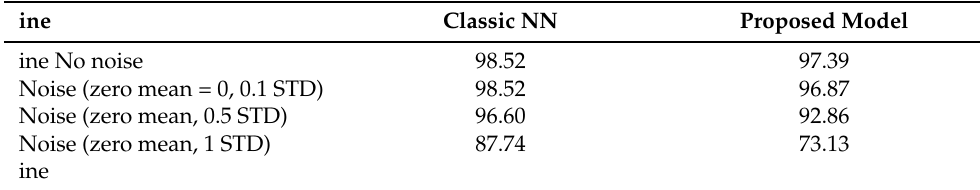
Table 4. Generalization accuracy (%) on holdout test sets for MNIST.